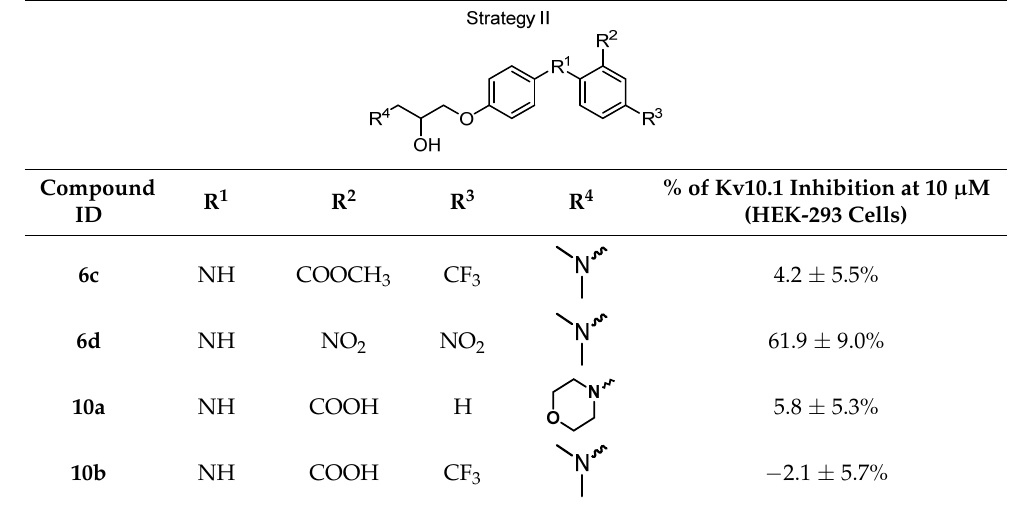
Table 2. Cont. Table 2. Structures and potencies of compounds from Strategy II.